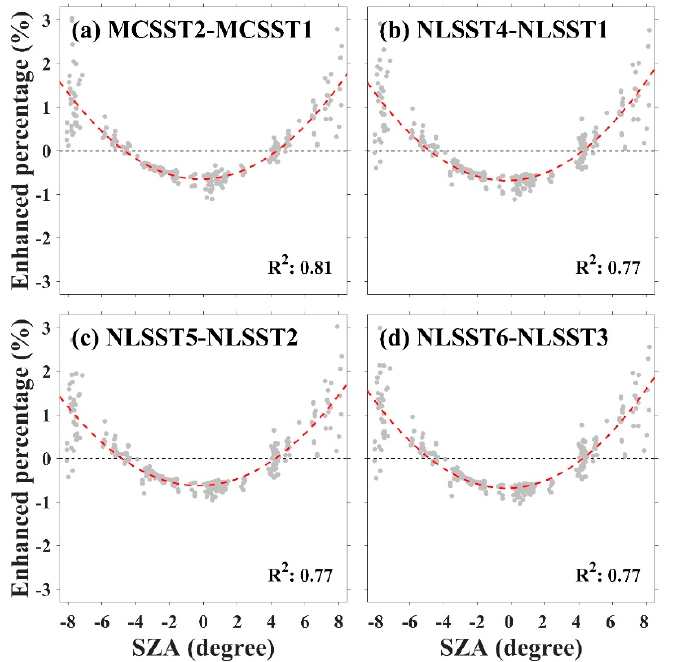
Figure 10. Comparison of enhanced percentage with satellite zenith angle (SZA) (enhanced percentage: (SST with SZA term – SST without SZA term) / SST with SZA term) using ( a ) MCSST2 and MCSST1, ( b ) NLSST4 and NLSST1, ( c ) NLSST5 and NLSST2, and ( d ) NLSST6 and NLSST3, where the red dashed lines represent the 2nd order polynomial fitted lines.